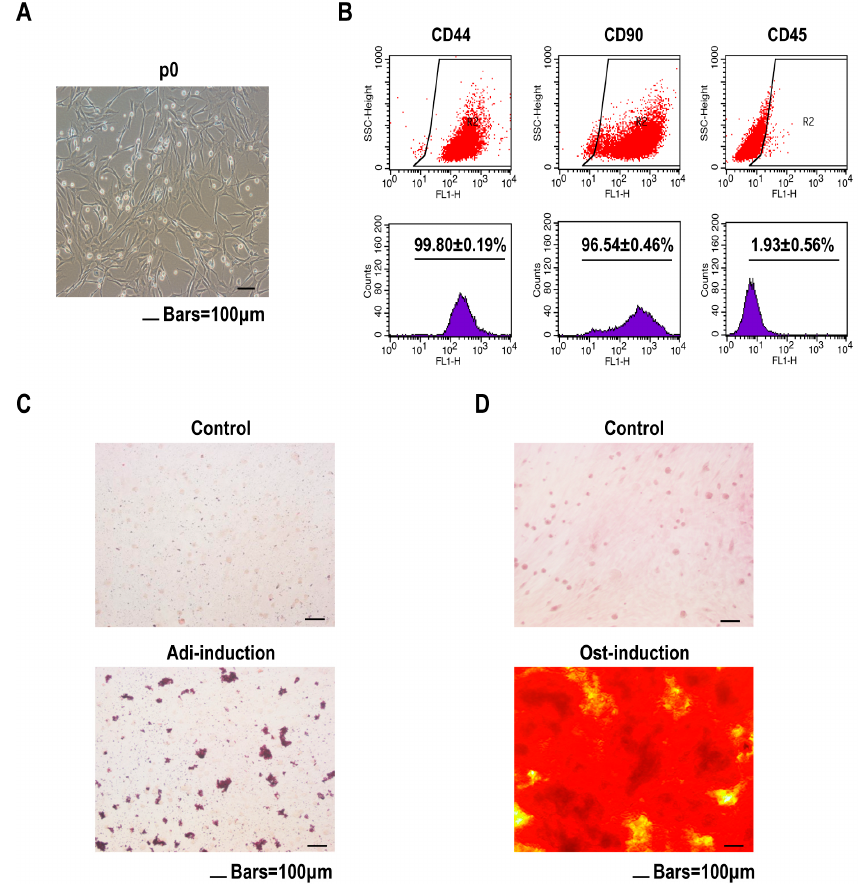
Figure 1. Prepared bone marrow mesenchymal stem cells (BMMSCs) have good purity and a high potential to differentiate. BMMSCs were cultured for 4 days. ( A ) Cell morphology of BMMSCs was shown under a light mirror. ( B ) The cell surface markers of BMMSCs were determined by flow cytometry analysis (mean ± SD, n = 3). BMMSCs were treated for adipogenic induction for 21 days.